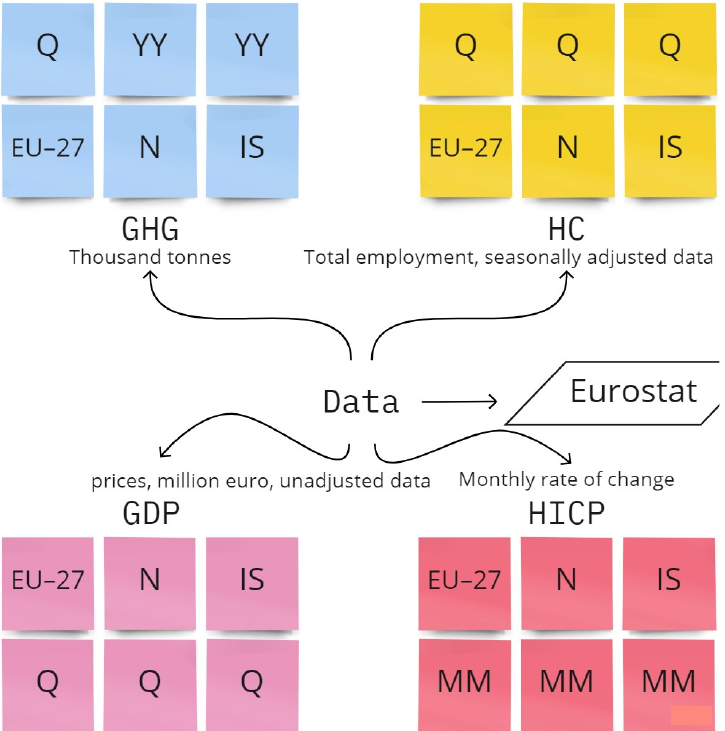
Figure 2. Data extraction procedure for the main objective aim of the research. Note: MM—monthly,